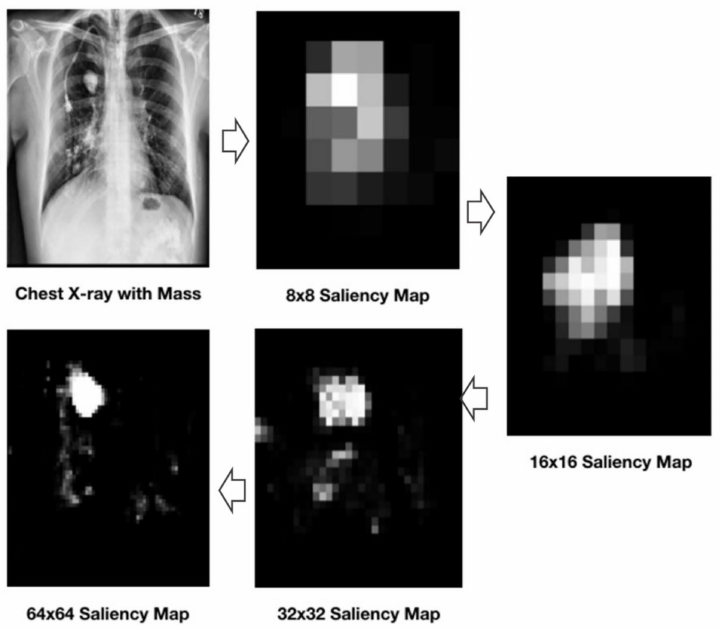
Figure 15. Illustration of CXR with saliency maps of increasing